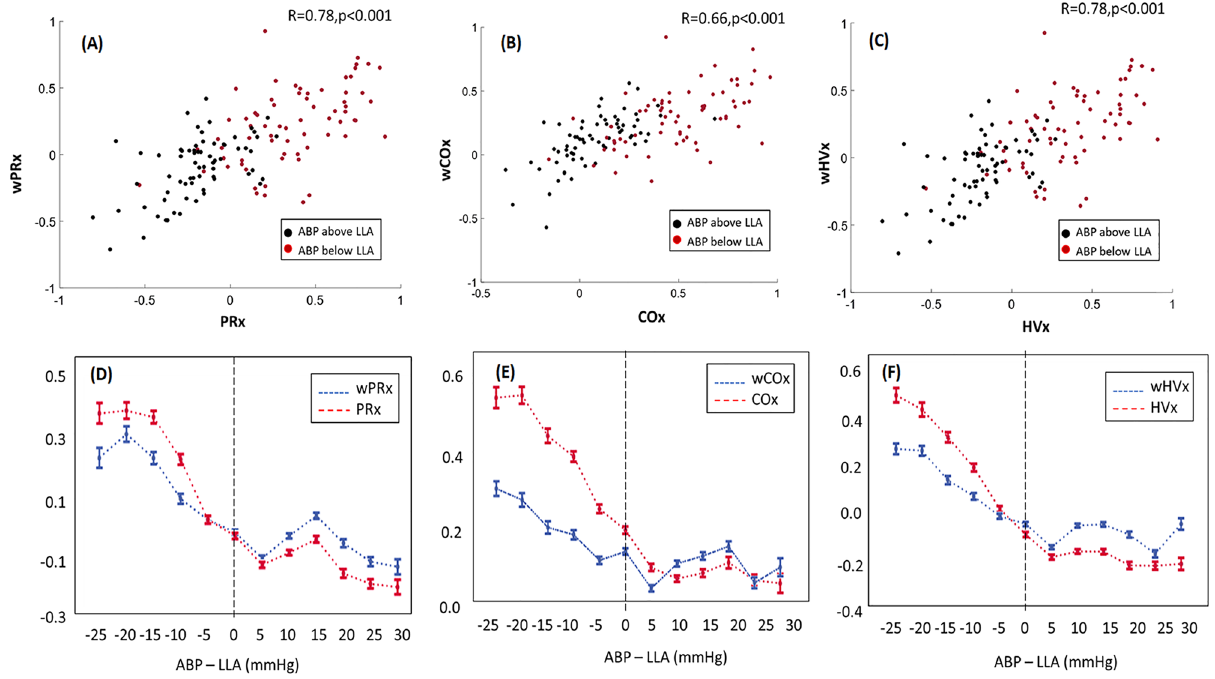
Figure 1. Both wavelet and correlation indices increased while mean arterial blood pressure (ABP) decreased below the lower limit of autoregulation (LLA). ( A – C ) In paired comparisons among 68 piglets, the wavelet autoregulation indices (wPRx, wCOx, wHVx) and correlation indices (PRx, COx and HVx) correlated with each other. Each piglet provided one index value averaged from ABP above the LLA and one index from ABP below the LLA, thereby generating 136 data points per graph. The black squares are index values when ABP exceeded the LLA. The red dots are index values when ABP was below the LLA. ( D – F ) Graphical depiction of the indices across changes in blood pressure. Each piglet’s ABP LLA is centered at zero on the x-axis (dashed line) to show the wavelet method (blue lines) and correlation method (red lines) responses to changes in blood pressure. Data are shown as mean ± standard error of the